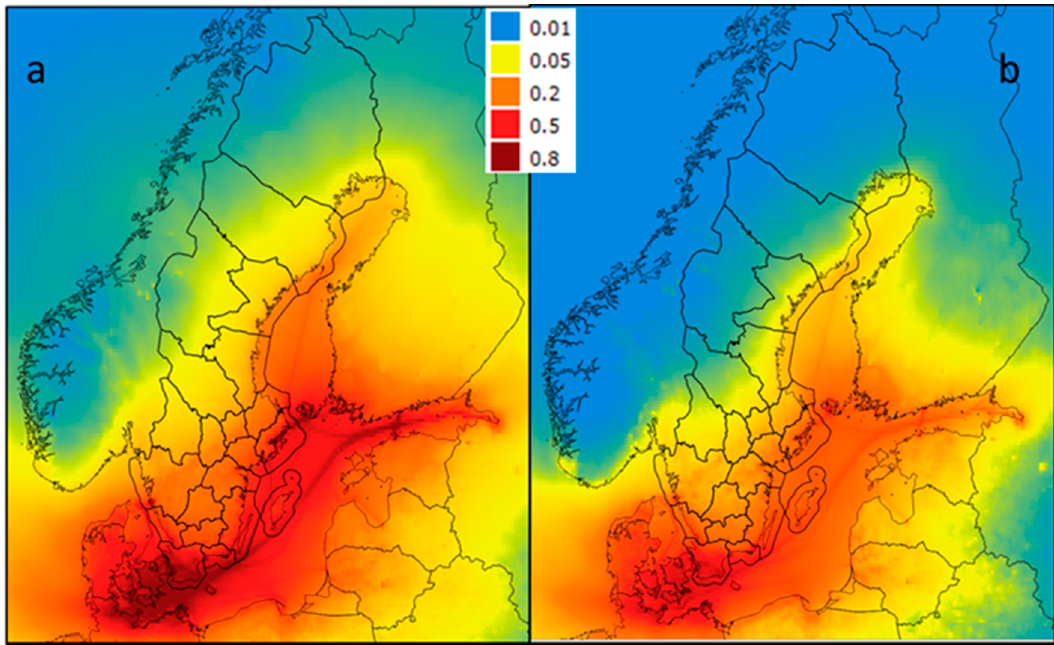
Figure 4. Comparison of the contribution from Baltic Sea shipping to PM 2.5 (µg/m 3 ) from ship emissions in Sweden and the surrounding area with the low-resolution EMEP model ( a ) high-sulfur; ( b ) low-sulfur.